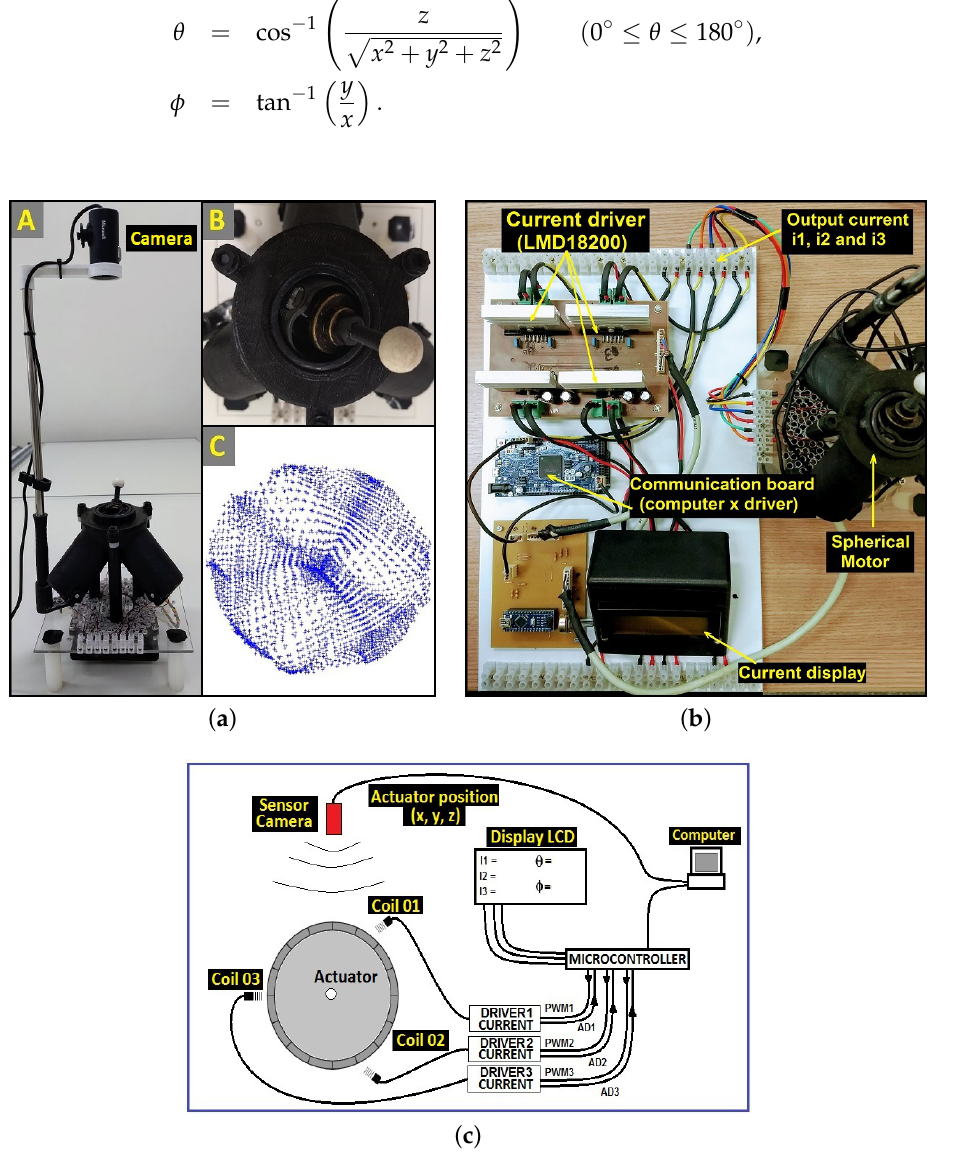
Figure 5. ( a ) A: Camera system mounted above the spherical motor; B: camera’s view of the rotor; C: points collected within the rotor’s workspace. ( b ) Board dedicated to computer communication with current driver. ( c ) Illustration of the data acquisition